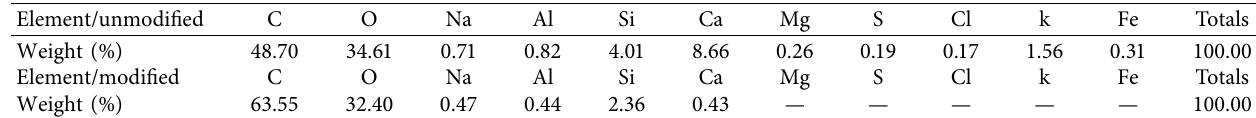
Table 2: Mass ratio of elements.